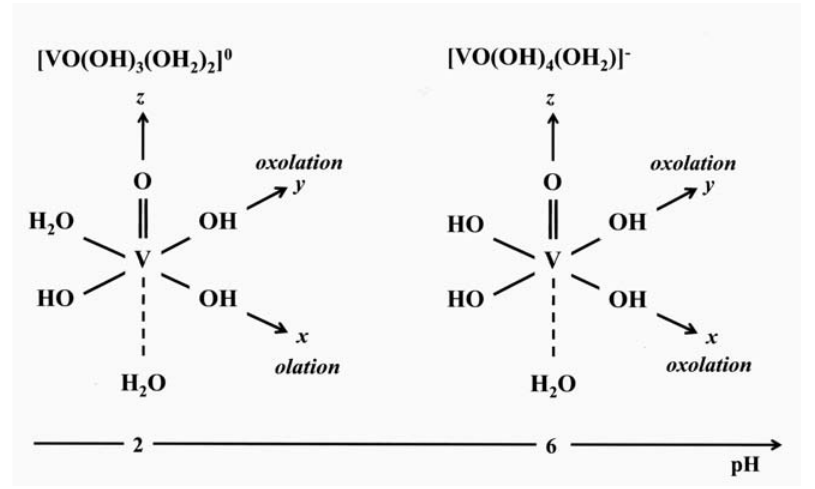
Figure 3. Molecular structure of V V precursors in the pH range